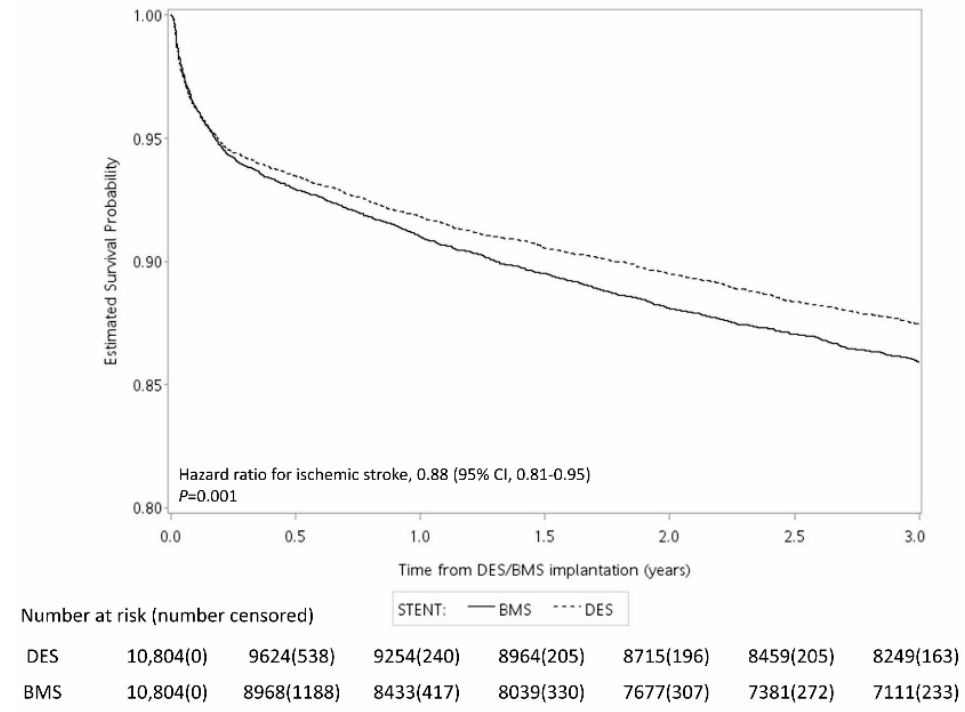
Figure 3. Kaplan–Meier curve for the risk of ischemic stroke within three years after surgery.